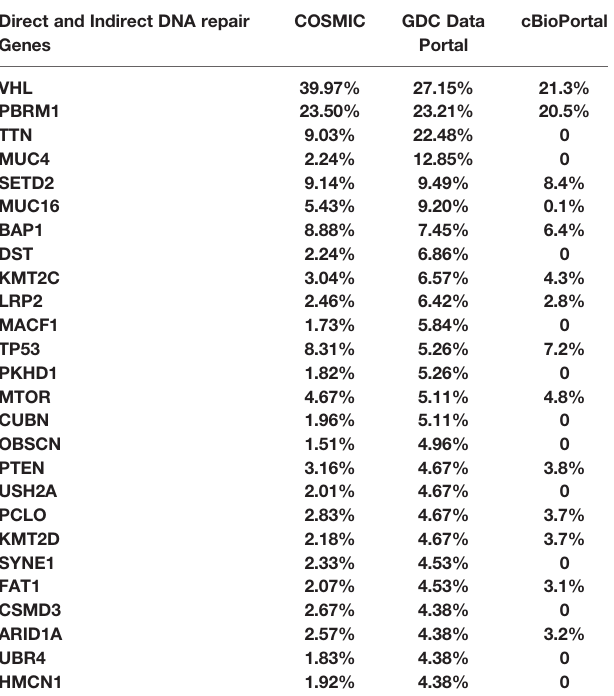
TABLE 2 | COSMIC, GDC Data Portal, and cBioPortal were used to explore the rate of mutations in direct and indirect DNA repair genes in RCC tissues from the TCGA